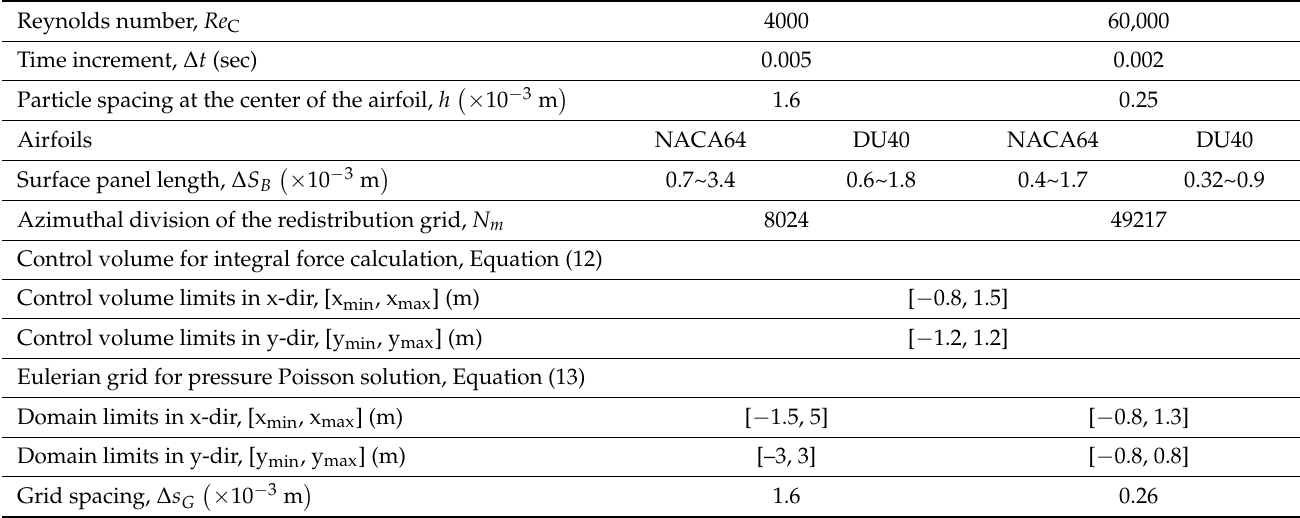
Table 1. Numerical setup in the vortex particle method (VPM).